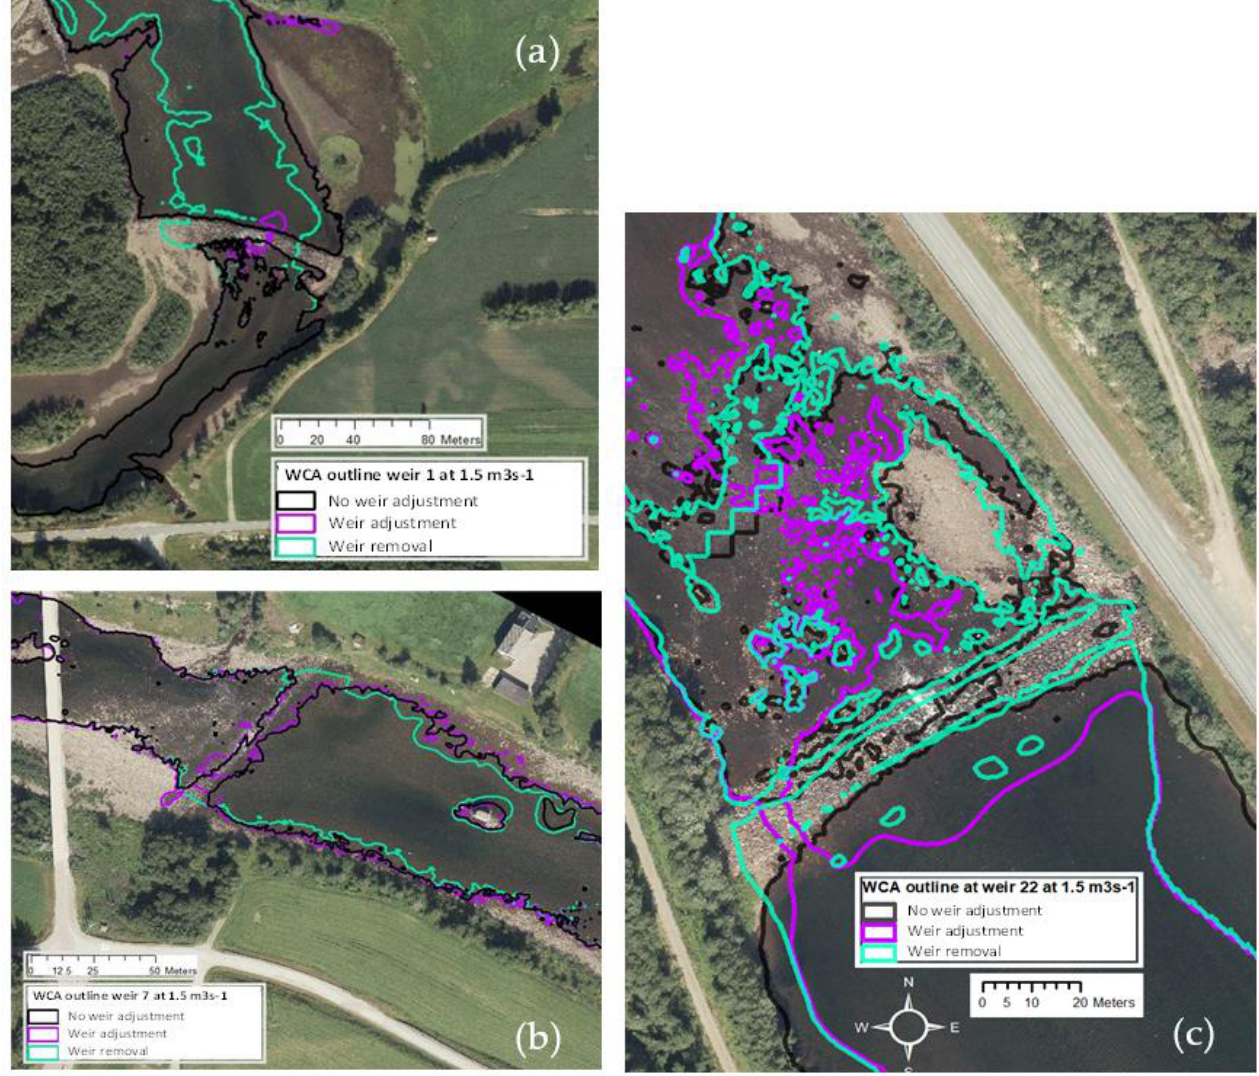
Figure 8. Results on water-covered area outline at ( a ) weir 1, ( b ) weir 7, and ( c ) weir 22 at a simulated flow of 1.5 m 3 /s. The outline colors of black, purple, and light green represent original weir, adjusted weir, and removed weir, respectively.